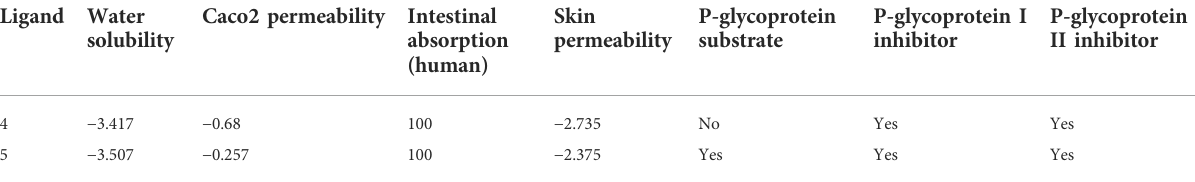
The red colour indicates that the ligand does not meet the criteria of the corresponding parameter